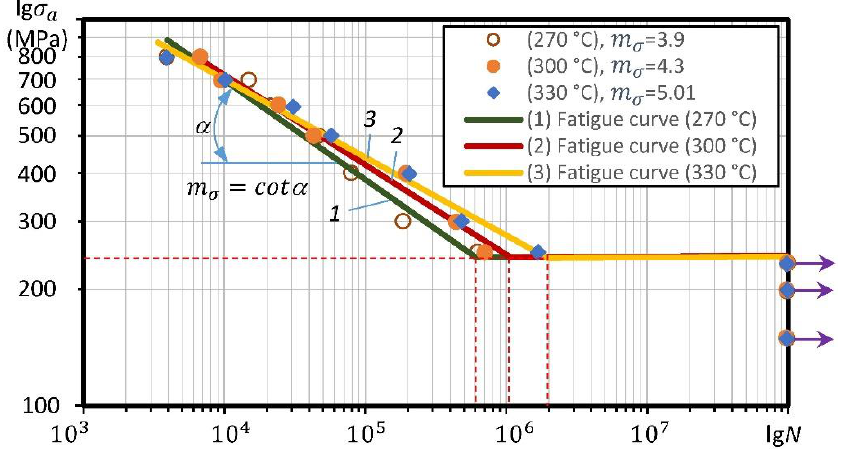
Figure 8. Mechanical rotating bending fatigue of ADI treated at different austempering temperatures 270 °C, 300 °C, and 330 °C.